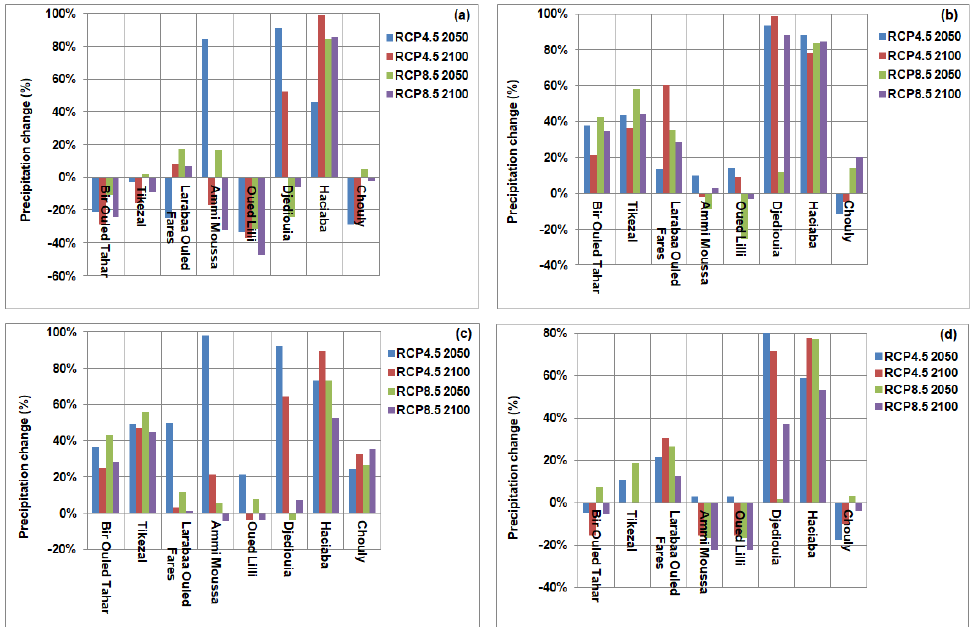
Figure 7. Changes in summer precipitation relative to the historical period under two scenarios (RCP4.5 and RCP8.5): ( a ) quantile mapping, ( b ) scaled distribution mapping, ( c ) quantile delta mapping, and ( d ) RAW.